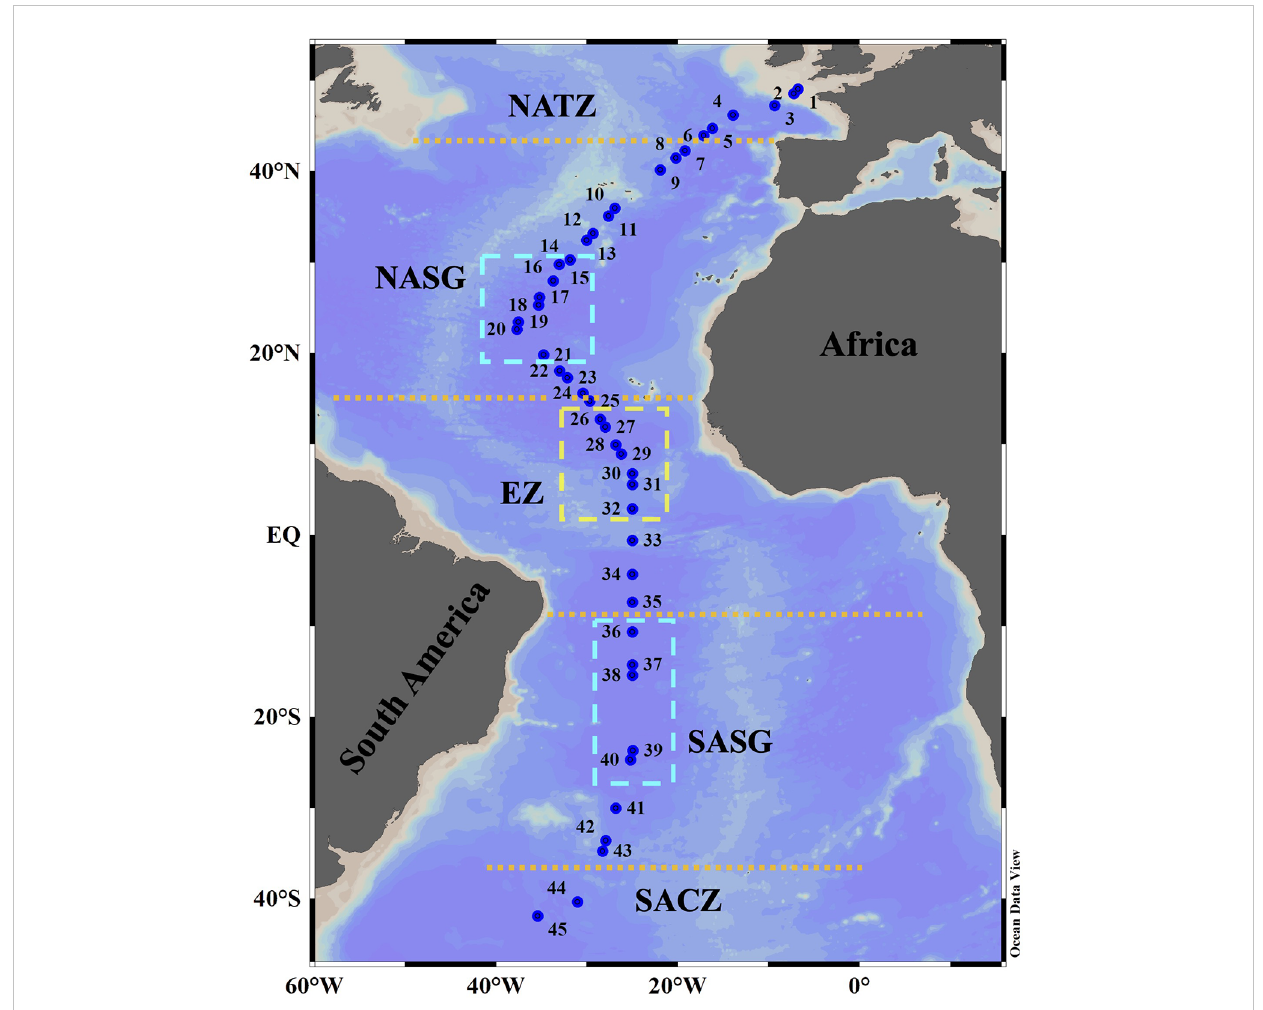
FIGURE 1 Location of sampling stations on the AMT29 cruise. The boundary positions (orange dotted lines) of the North Atlantic Transition Zone (NATZ), Northern Atlantic Subtropical Gyre (NASG), Equatorial Zone (EZ), Southern Atlantic Subtropical Gyre (SASG) and South Atlantic Convergence Zone (SACZ) were determined according to environmental factors as de fi ned by Aiken et al. (2000), Hooker et al. (2000) and Aiken et al. (2017). The yellow box indicates the Equatorial Zone centre. The cyan boxes delimit gyre